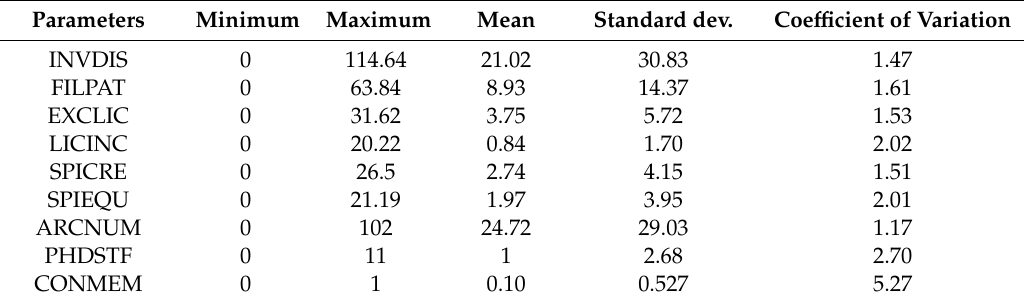
Table 4. Descriptive statistics for all variables.